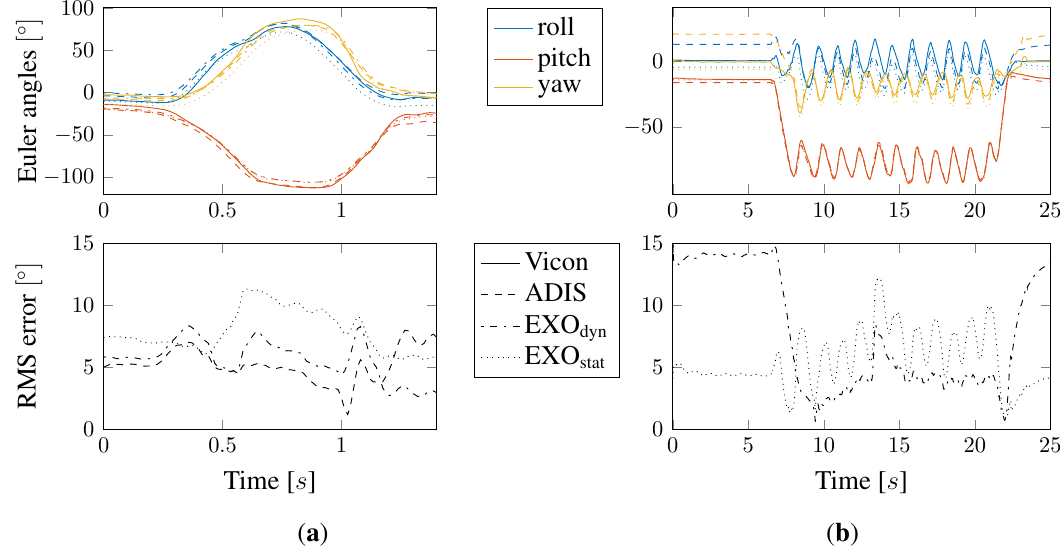
Figure 9. ( a ) Comparison of estimated orientation results versus real Vicon tracking data on arbitrary trajectory and RMS error of ADIS data, as well as dynamically, statically and non-calibrated EXO data and ( b ) the worst case scenario: comparison between the static and dynamic calibration algorithm within both fast and zero movements. The line styles are valid for all four graphs; the different colors specify the three possible